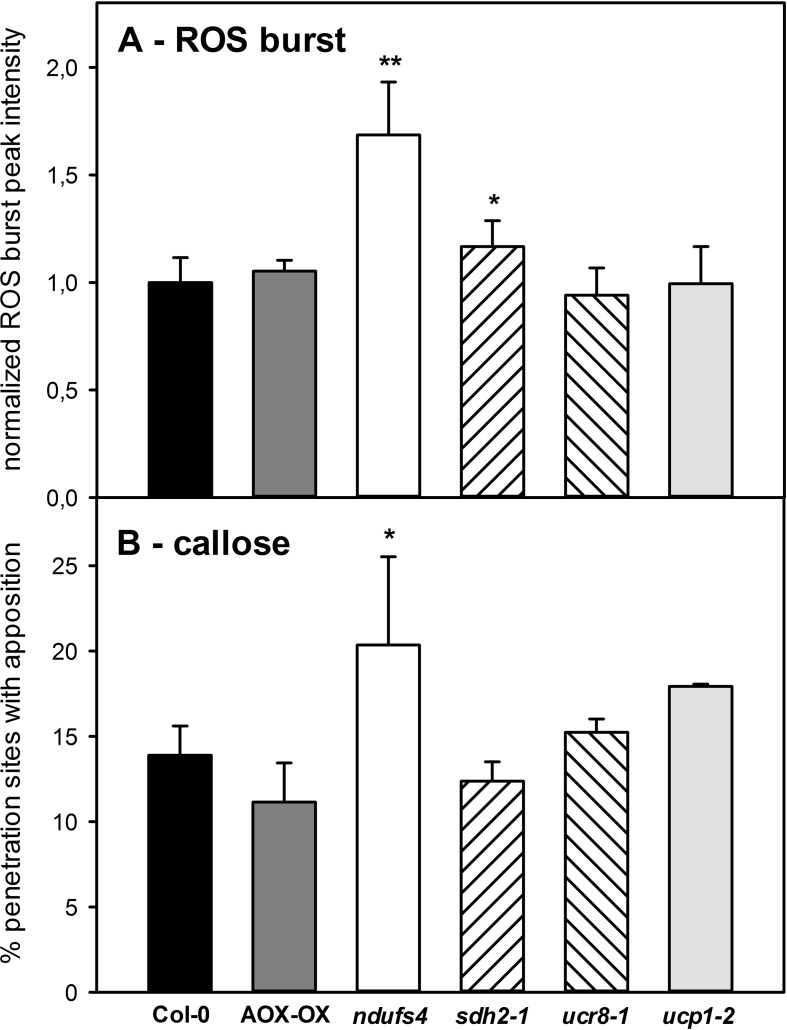
Basal defense responses in mETC mutants. To obtain a measure for the inducibility of basal defense responses in mETC mutants, the flg22-induced ROS burst (A) and the degree of callose apposition formation (B) were determined. Col-0 (black bars), AOX-OX (dark gray bars), ndufs4 (white bars), sdh2-1 (left hatched bars), ucr8-1 (right hatched bars), ucp1-2 (light gray bars). Significant differences to Col-0 in a pairwise t-test are indicated by asterisks with *: p < 0.05 and **: p < 0.005. (A) Maximum ROS production in fully expanded leaves of 5-week-old plants was determined after challenge with 1µM flg22 by the luminol assay. Flg22-induced luminescence was recorded in three independent experiments with seven biological replicates each. Maximum luminescence was normalized to the average value of the respective wild-type controls in each experiment before means over all experimental replicates were calculated. Data are given ± SE. (B) Callose papillae formation in response to Colletotrichum higginsianum infection was quantified 2.5 dpi after C. higginsianum infection of Arabidopsis thaliana leaves with 2·106
C. higginsianum conidiospores/ml. Four leaves of four independent plants per genotype were stained with aniline blue and for each leaf, at least 250 appressoria from different parts of the leaf blade were scored for the presence of callose papillae below fungal appressoria. In (B), the fraction of appressoria exhibiting callose papillae is depicted. Data are means of four biological replicates ± SE.